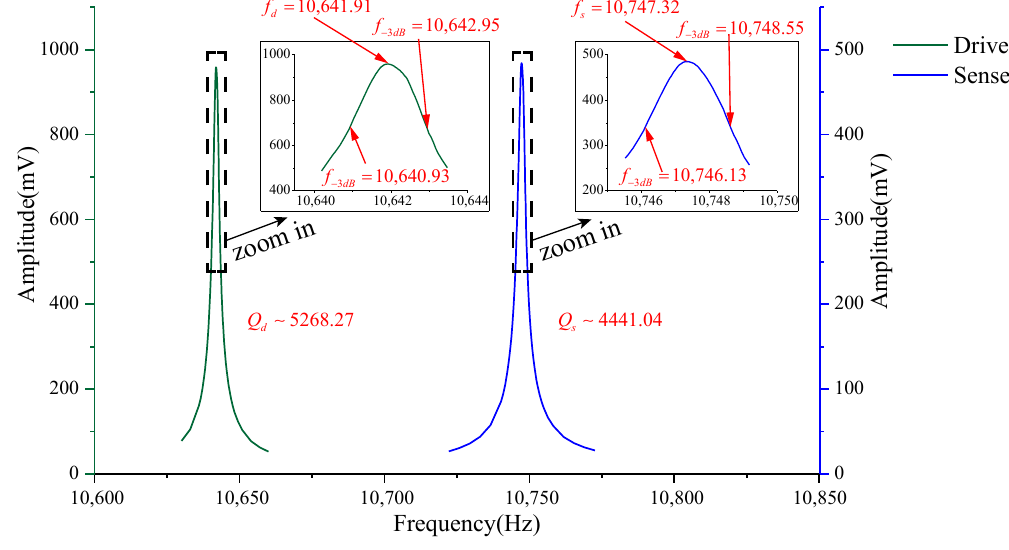
Figure 18. Experimental input-output amplitude-frequency responses of the